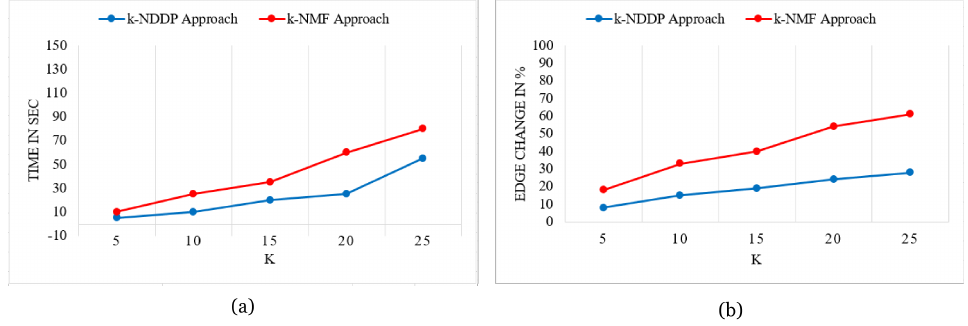
Figure 9. Comparison of k -NDDP with k -NMF(SOCFB-USFCA72). ( a ) Time; ( b ) edge